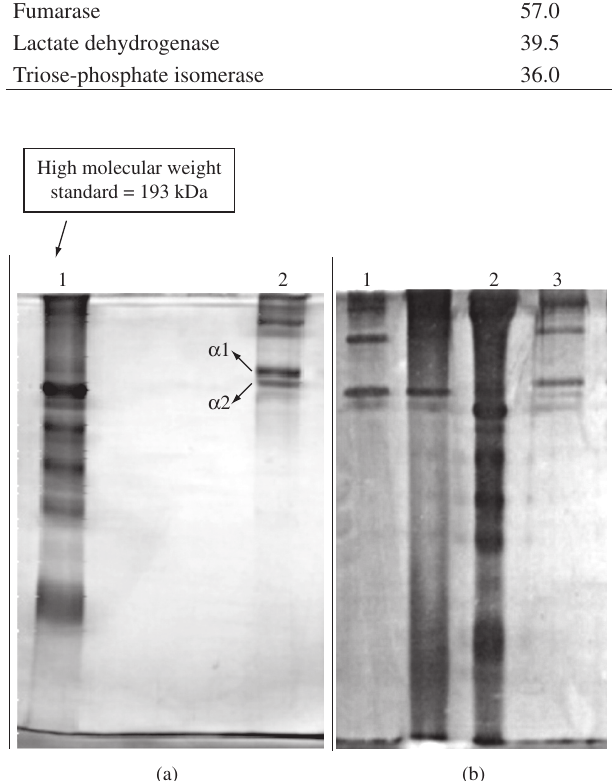
Figure 2. Electrophoresis in 12% sodium dodecylsulfate-polyacrylamide (A) molecular weight standard (SDS, 7B – Sigma) (1), DEAE-sepharose purified collagen (COL) showing typical bands of the type I collagen; (B) commercial collagen (type I collagen – Sigma) used as purity control (1), molecular weight standard (Table 2) (2) and COL